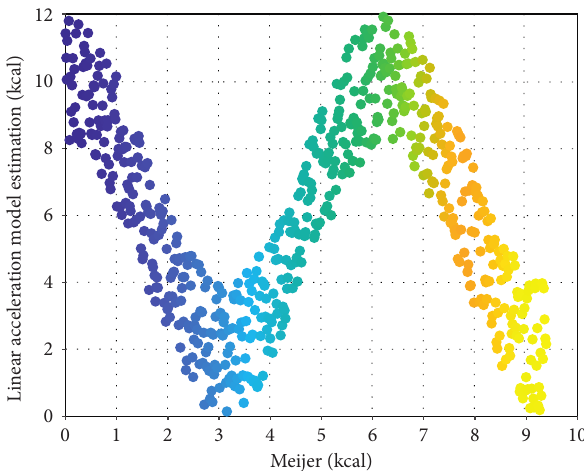
Figure 5: Schematic diagram of linear analysis of the estimated value of linear acceleration model and the calculated value of Meijer